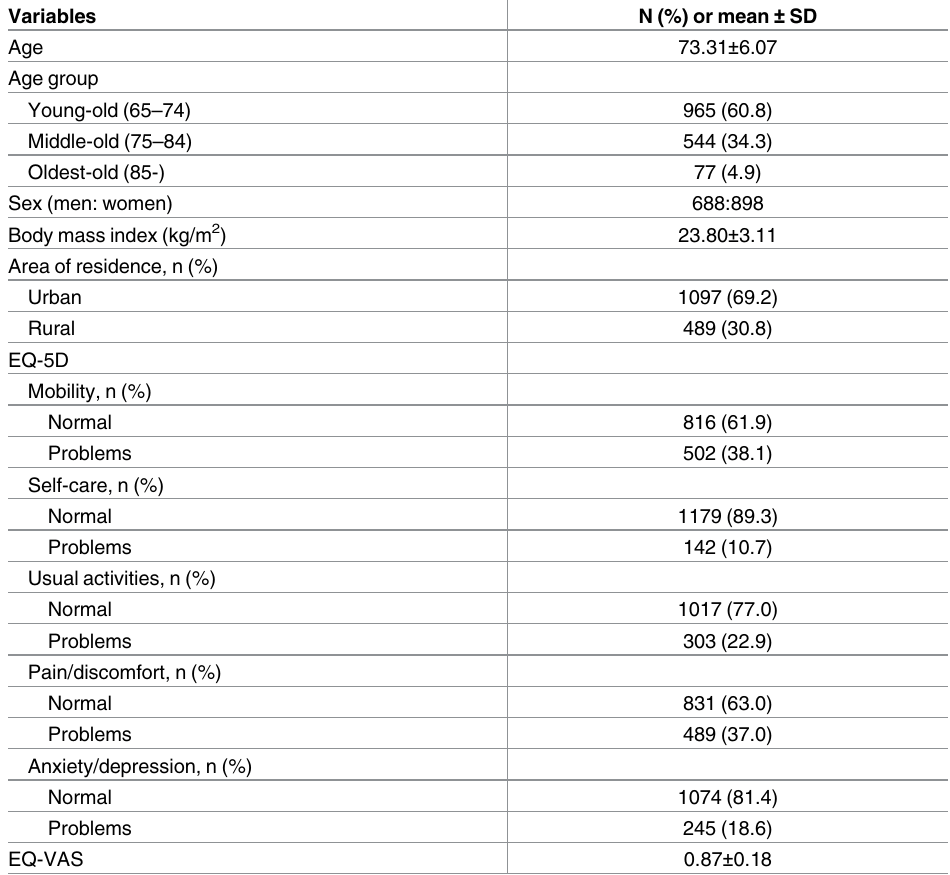
Table 1. General characteristics of the older